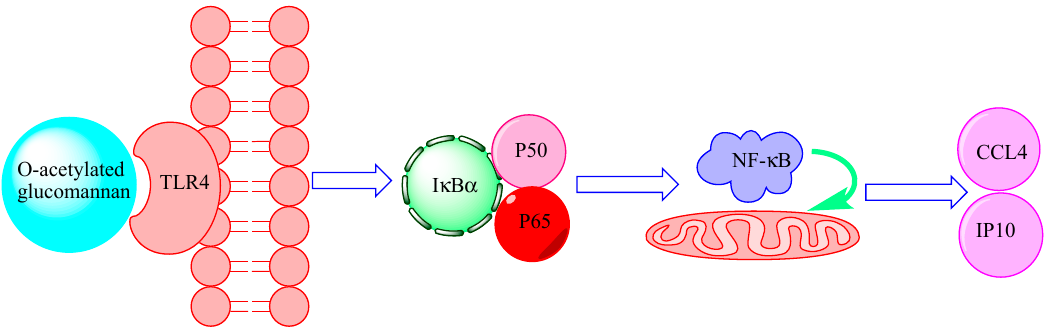
Figure 7. Schematic diagram depicting the immunomodulatory mechanism of O -acetylated glucomannan.